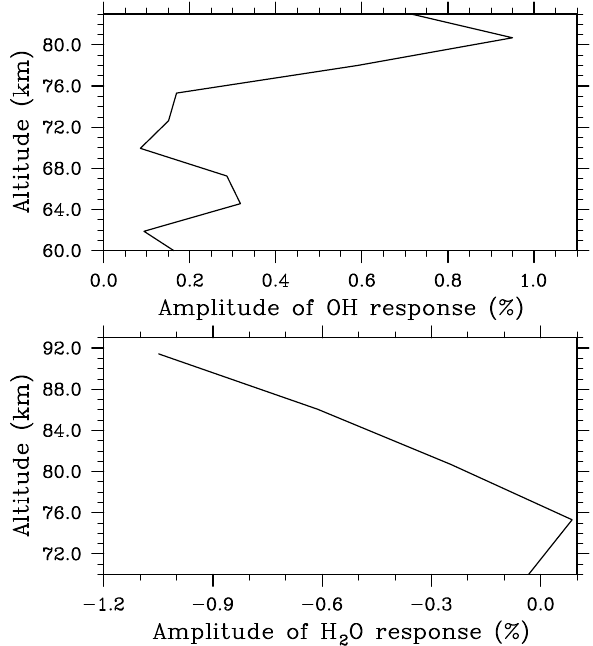
Fig. 8. OH (upper panel) and H 2 O (lower panel) sensitivities (in %) to 1% change of the SOLSTICE /SORCE Ly- α